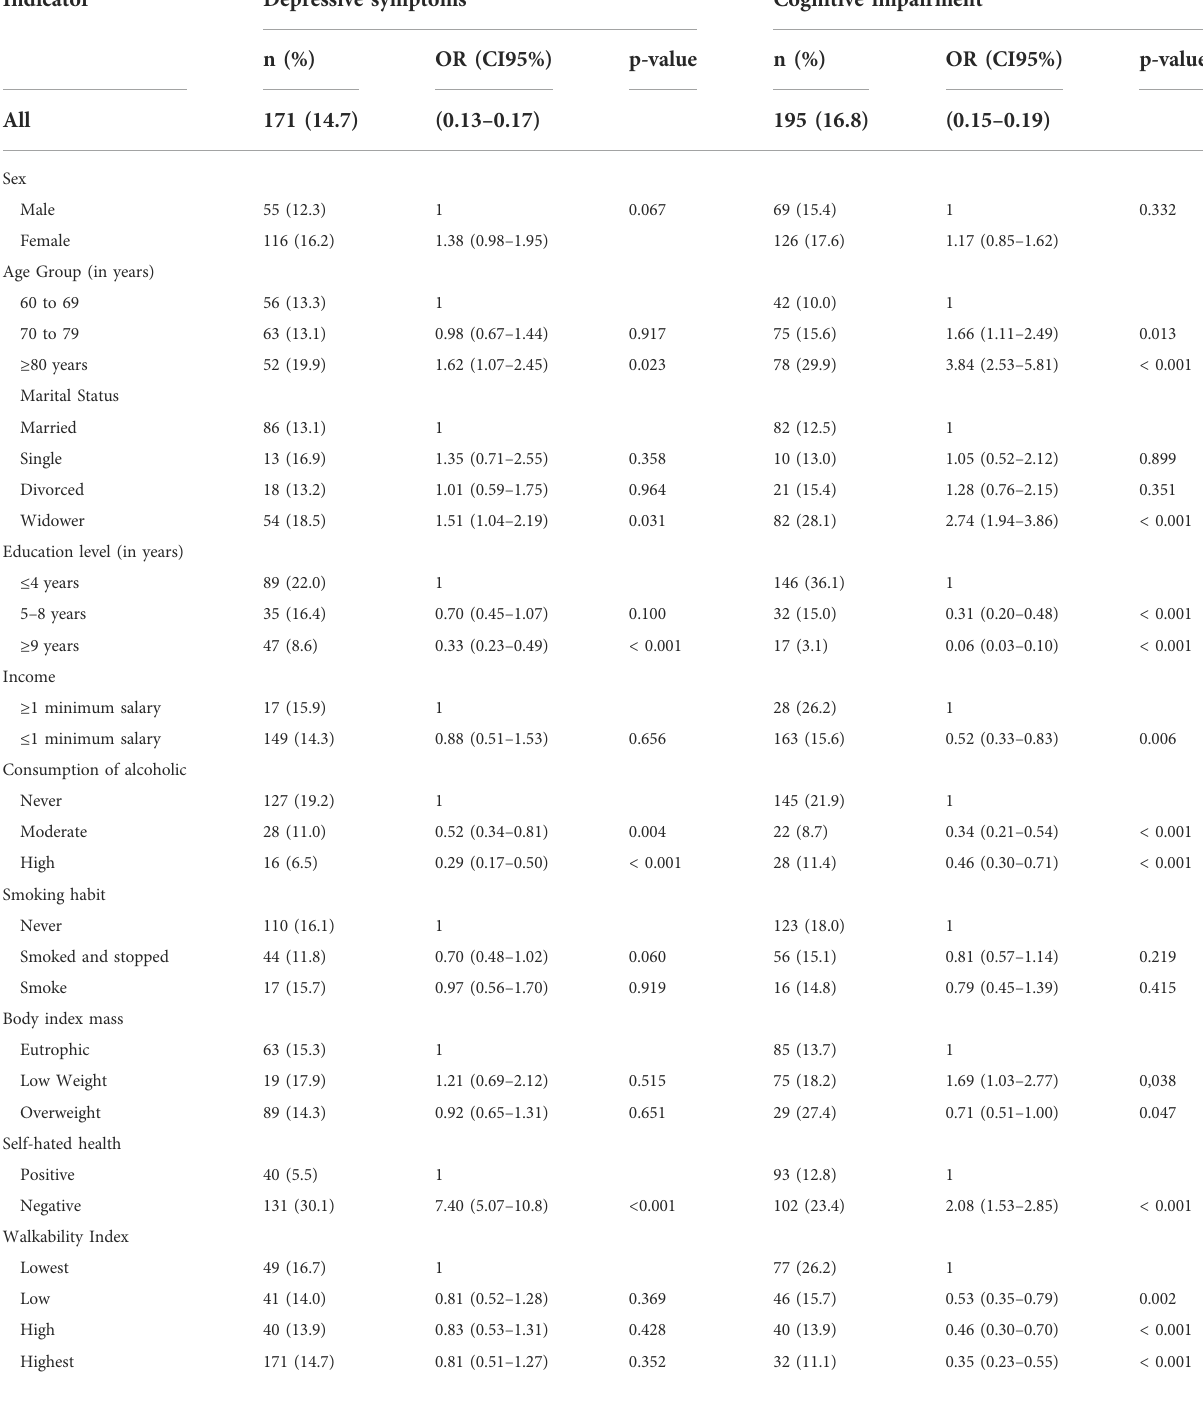
TABLE 2 Crude association between descriptive characteristics and mental health from older adults in Florianopolis, Brazil. EpiFloripa Aging Study, 2017 – 2019 (n =